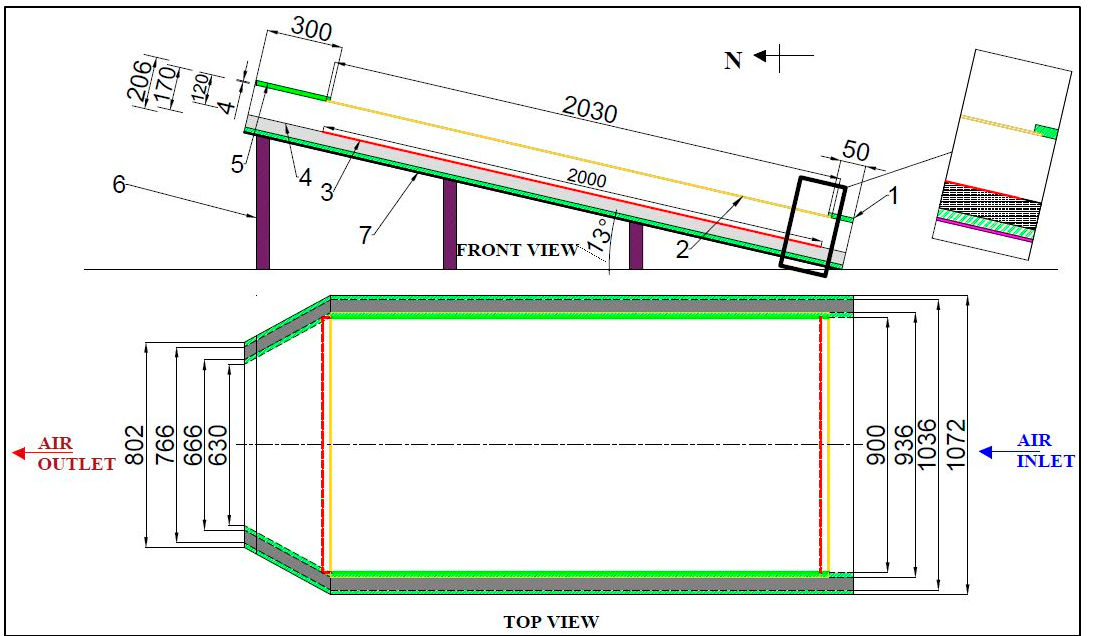
Figure 1. Detailed schematic layout of SAH: (1) wooden material for entrance section (in Green line), (2) toughened glass (in Yellow line), (3) aluminum absorber plate (Red line), (4) polyurethane foam (Grey hatch line), (5) wooden material for exit section (Green line), (6) M S steel stand for support (Purple line), and (7) wooden material (Green line) for the frame as an outer box of the solar air heater (All dimensions are in mm). Table 2. Material properties considered for simulation [37,38].